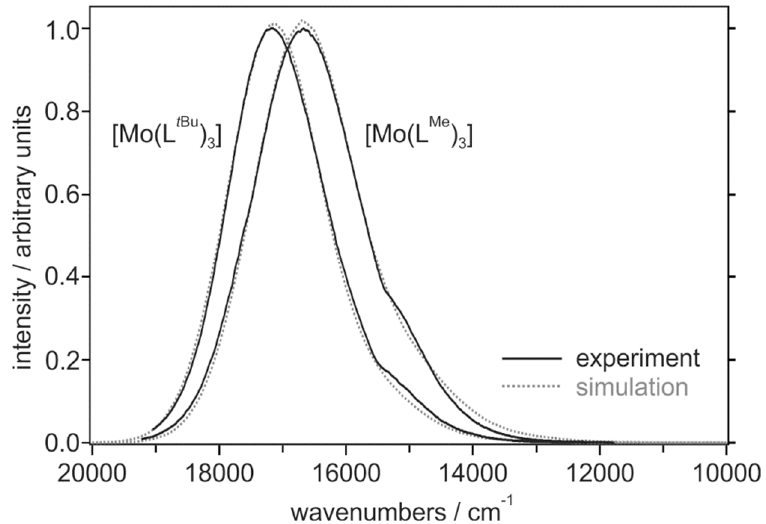
Figure 2. Luminescence spectra of [Mo(L Me ) 3 ] and [Mo(L t Bu ) 3 ] in n ‐ hexane at 20 °C following excitation at 500 nm (solid black trace) [25,27], along with simulated emission spectra according to Equation (3) (dotted gray traces).